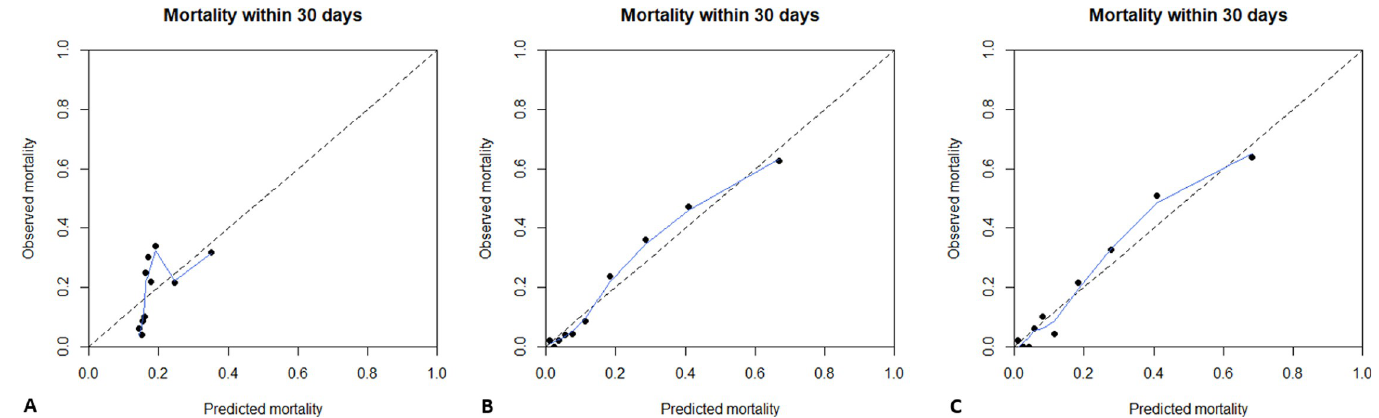
Fig 2. Calibration plot of prediction models. The figure shows the calibration plot of the model containing only d-dimer as a predictor ( A ), containing age, sex and comorbidities ( B ) and containing d-dimer, age, sex and comorbidities ( C ). The population was divided into ten groups (or deciles) based on their predicted mortality risk. (represented as black dots in the plot) The predicted probability of mortality according to the model is shown on the X-axis while the observed mortality is shown on the Y-axis. Groups with a higher predicted risk of mortality should have a higher observed risk. To examine calibration across the whole range, we also fitted a LOWESS (Locally Weighted Scatterplot Smoothing) line to the data. (shown here as a blue line) The dotted line represents perfect prediction (where the predicted risk is exactly the same as the observed risk).